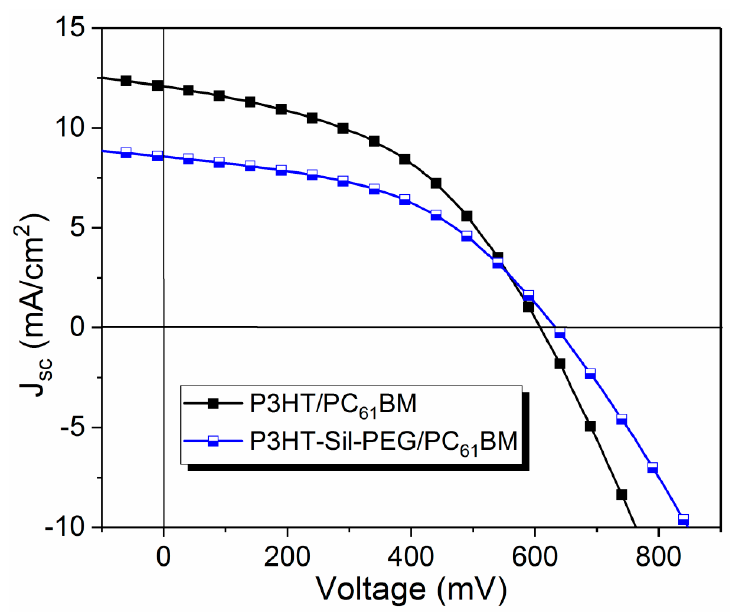
Figure 11. Current density–voltage (J–V) curves of device based on P3HT-Sil-PEG3:PC 61 BM BHJ and reference P3HT:PC 61 BM BHJ.